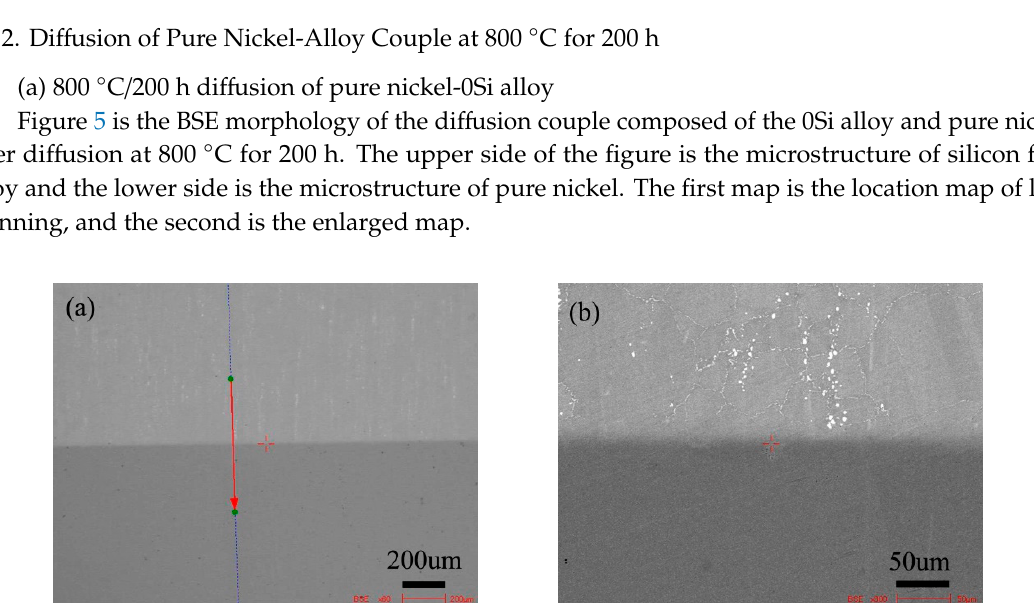
Figure 5. Microstructure of diffusion couple sample after 800 °C/200 h heat treatment: ( a ) composition line scan position of the sample and the upper side is 0Si alloy and lower side is pure nickel, ( b ) the enlarged view of figure a.